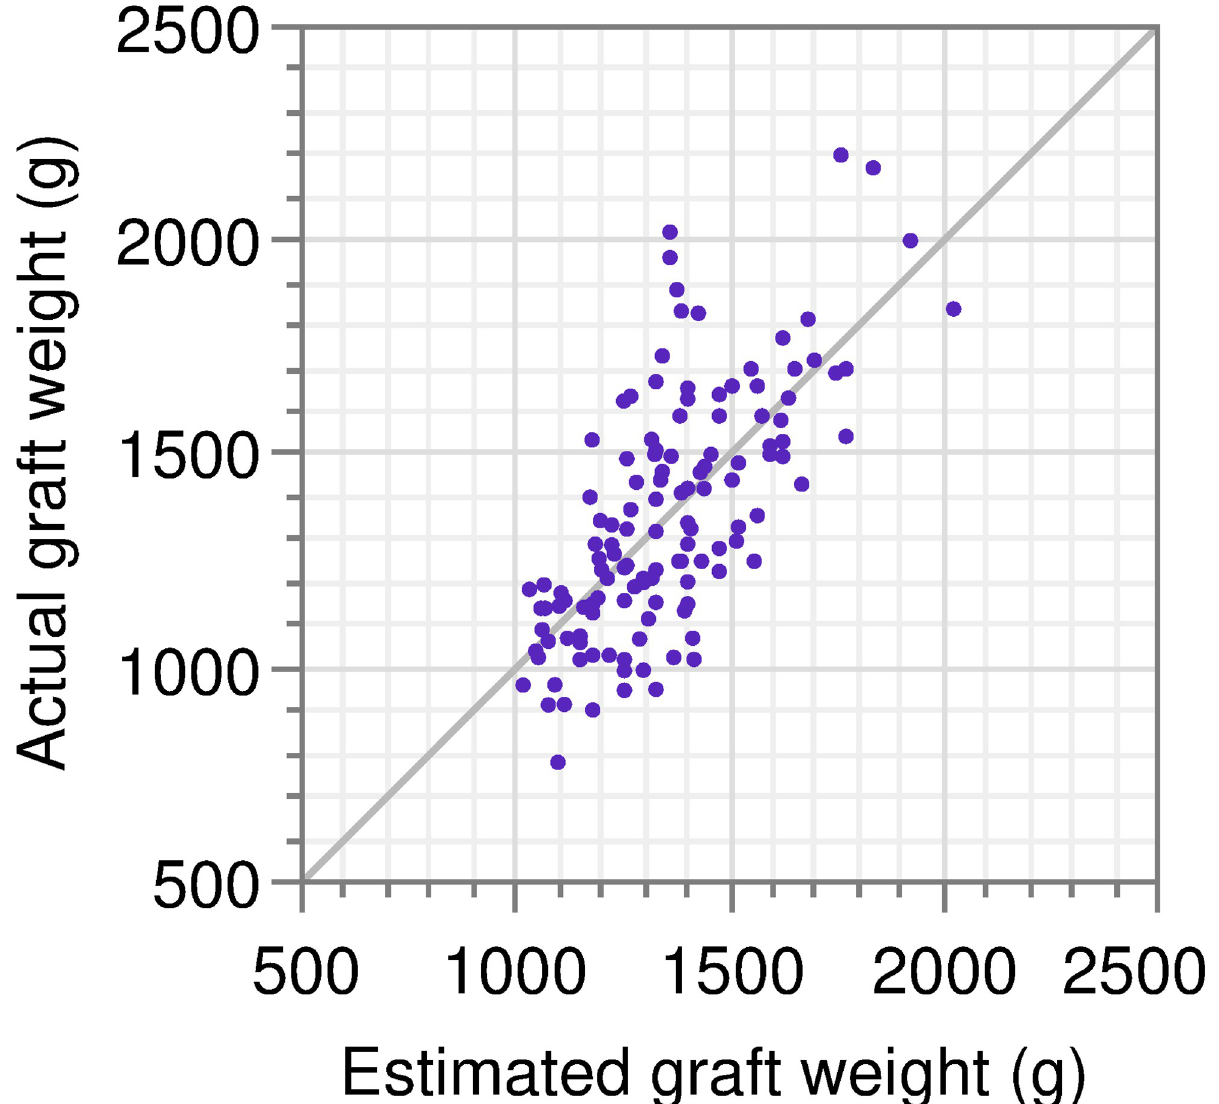
Fig 4. Actual vs . predicted plot of the final fitted model. Scatter plot between actual graft weight in the current cohort and estimated graft weight with the final fitted models using BW. The 45˚ line through the origin represents perfect precision.